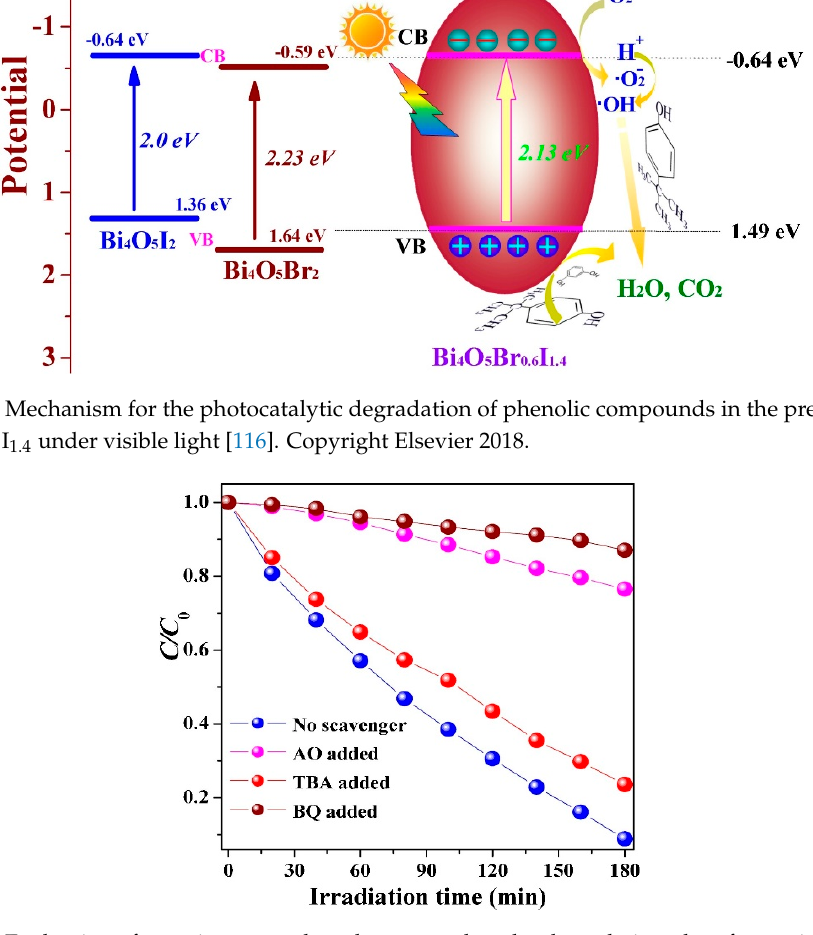
Figure 12. Evaluation of trapping agents based on a zeroth-order degradation plot of resorcinol given exposure to Bi 4 O 5 Br 0.6 I 1.4 and visible light [116]. Copyright Elsevier 2018.